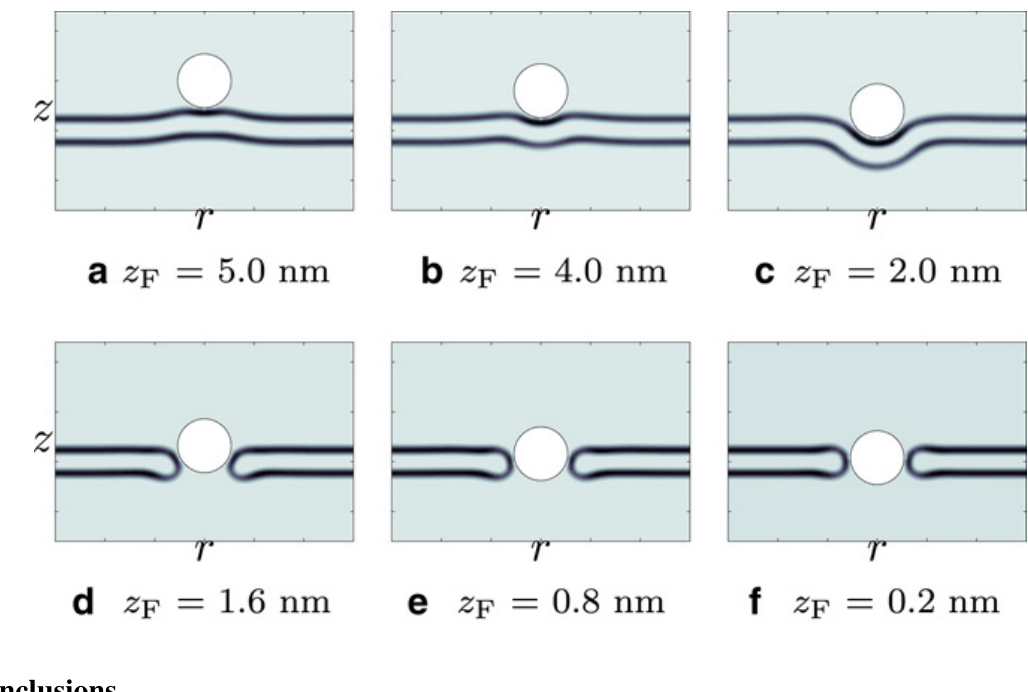
Figure 7. Volume fraction of head monomers, ϕ , in cylindrical coordinates ( z vs. r ) for a H tensionless membrane and a fully protonated G5 dendrimer with charge density of 1.55 nm (cid:0) 3 placed at vertical position z . Reprinted from [97], Copyright (2011), with permission from F